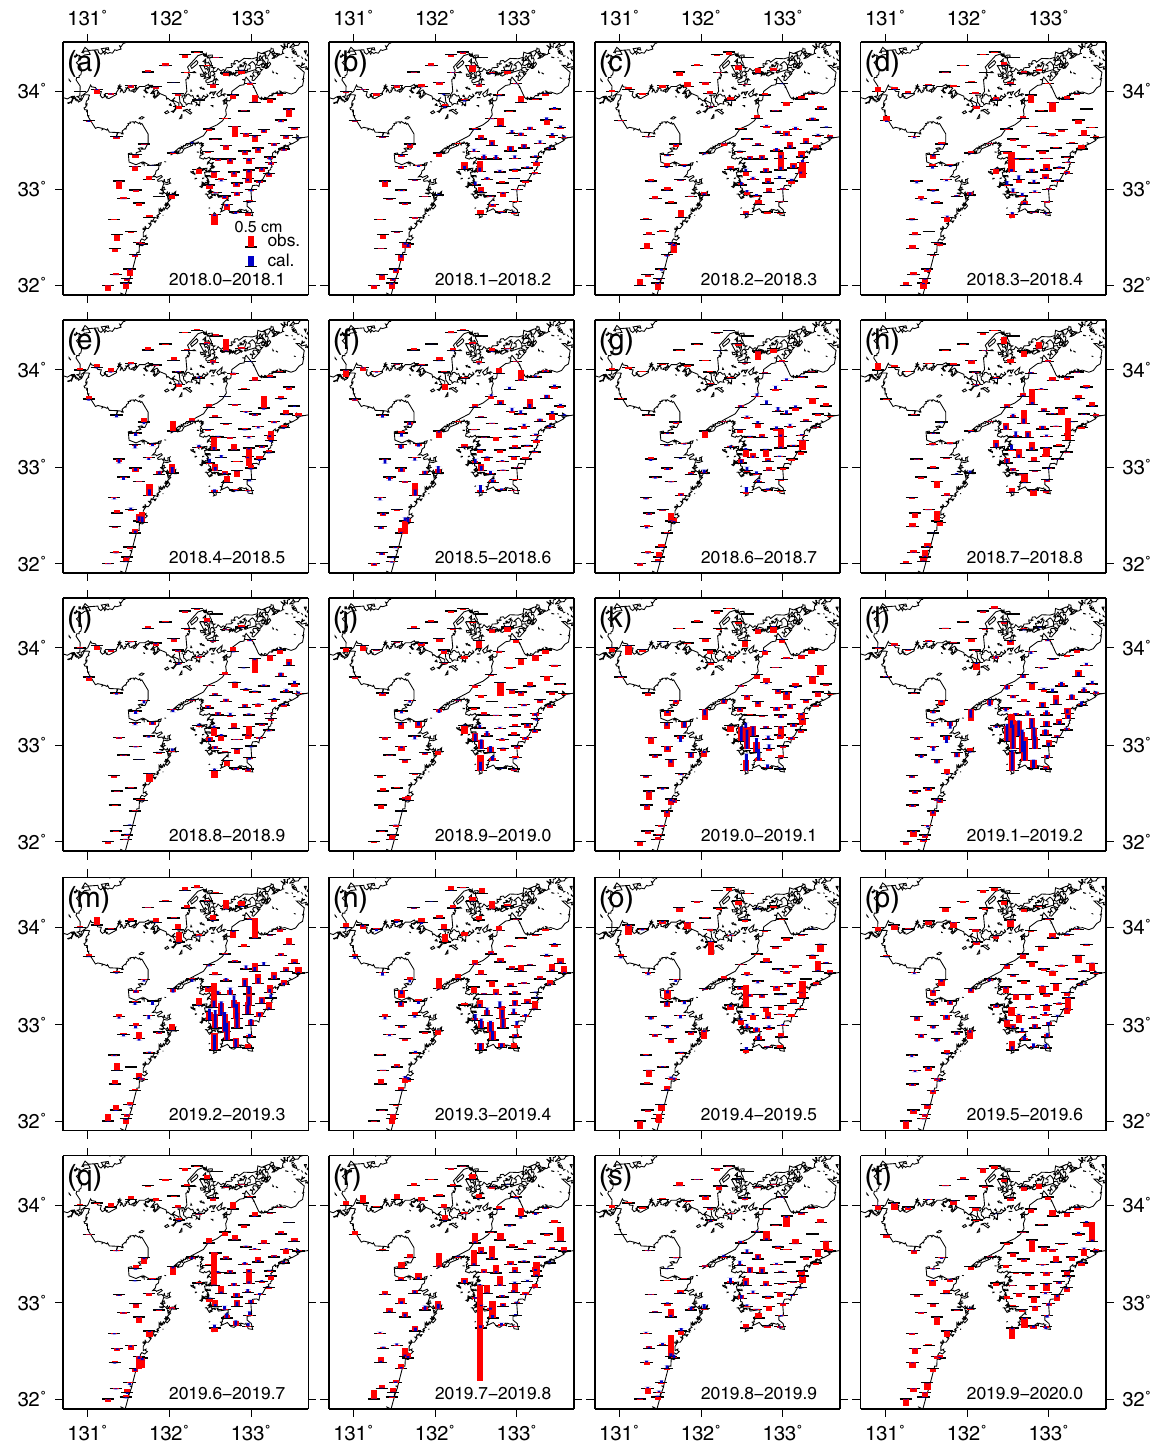
Figure 3. Same as Fig. 2 except for vertical displacement fields. The red and blue bars indicate the observed and calculated displacements obtained from the spatiotemporal slip distributions shown in Fig. 4, respectively. If the bars are above and below the black horizontal bars, which represent locations of the GNSS stations, they indicate uplift and subsidence, respectively. The scale of 0.5 cm for the bar is shown in ( a ). The map was created by using the Generic Mapping Tools (GMT) 15 (version: GMT 4.5.7, URL link: https:// www. gener ic- mappi ng- tools. org/ downl